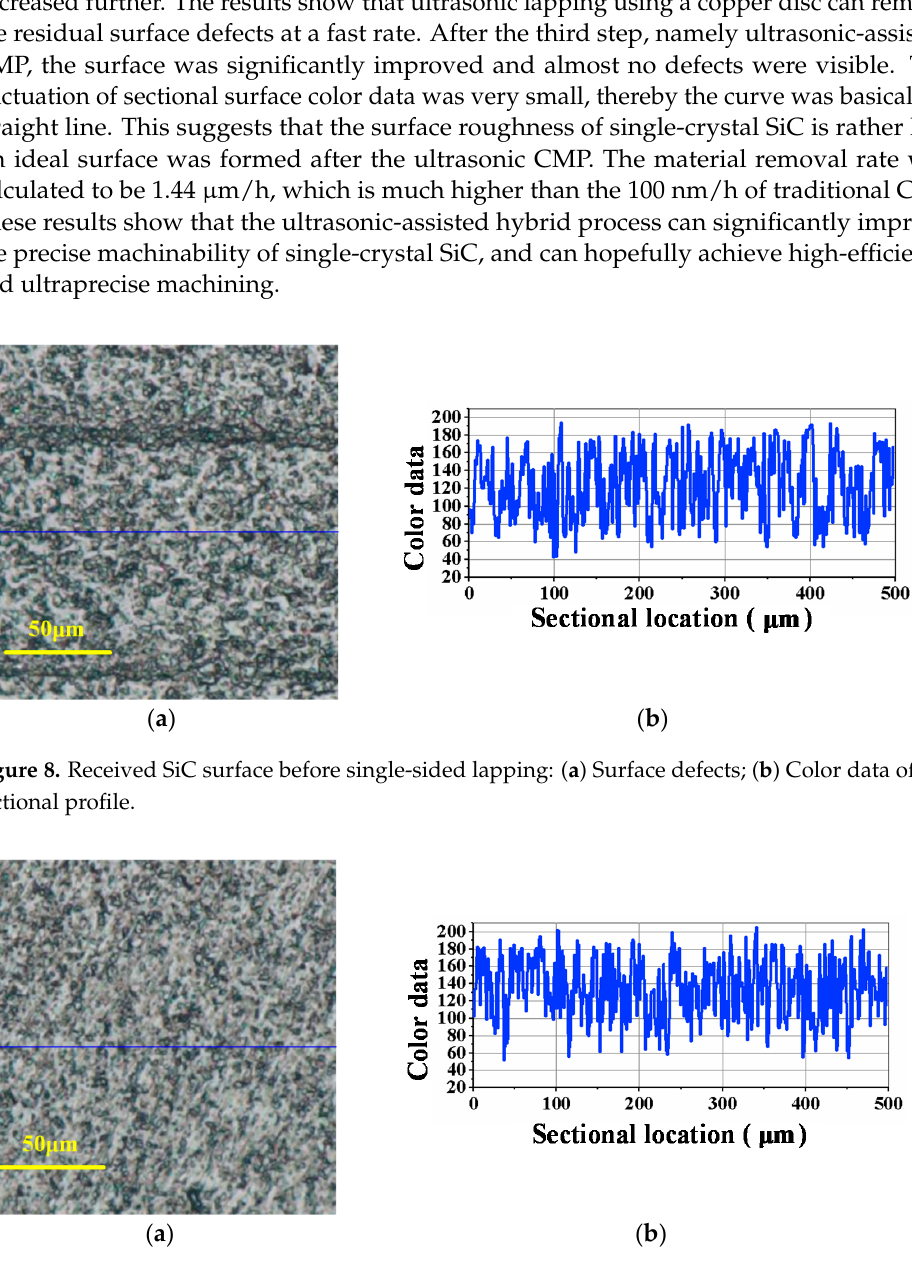
Figure 9. Optical image and sectional surface profile after ultrasonic-assisted lapping using cast iron disc (10.93 µ m/min): ( a ) Surface defects; ( b ) Color data of the sectional